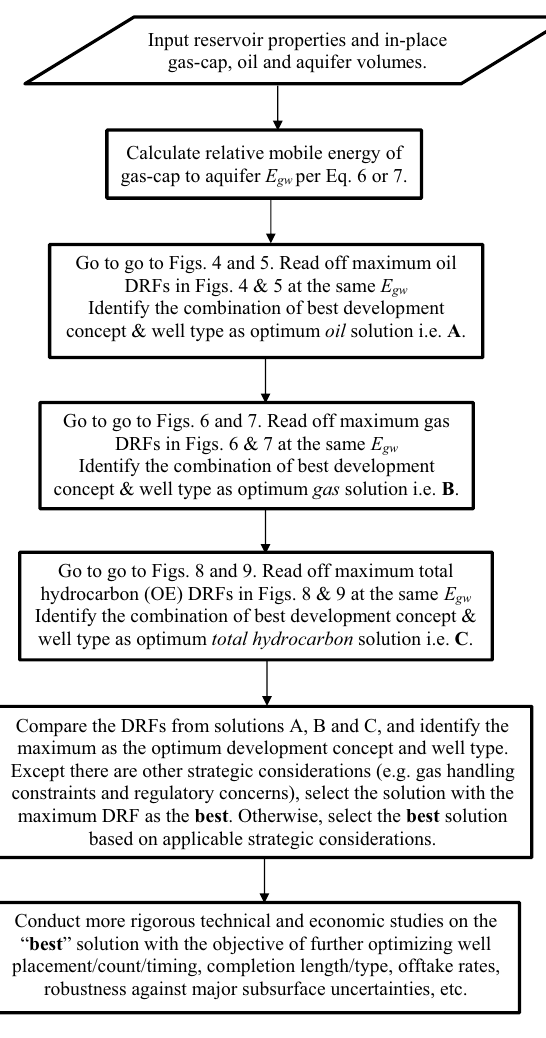
Fig. 10 A workflow to aid the implementation of the new technique of rapid screening of oil-rim reservoirs for development and manage- ment